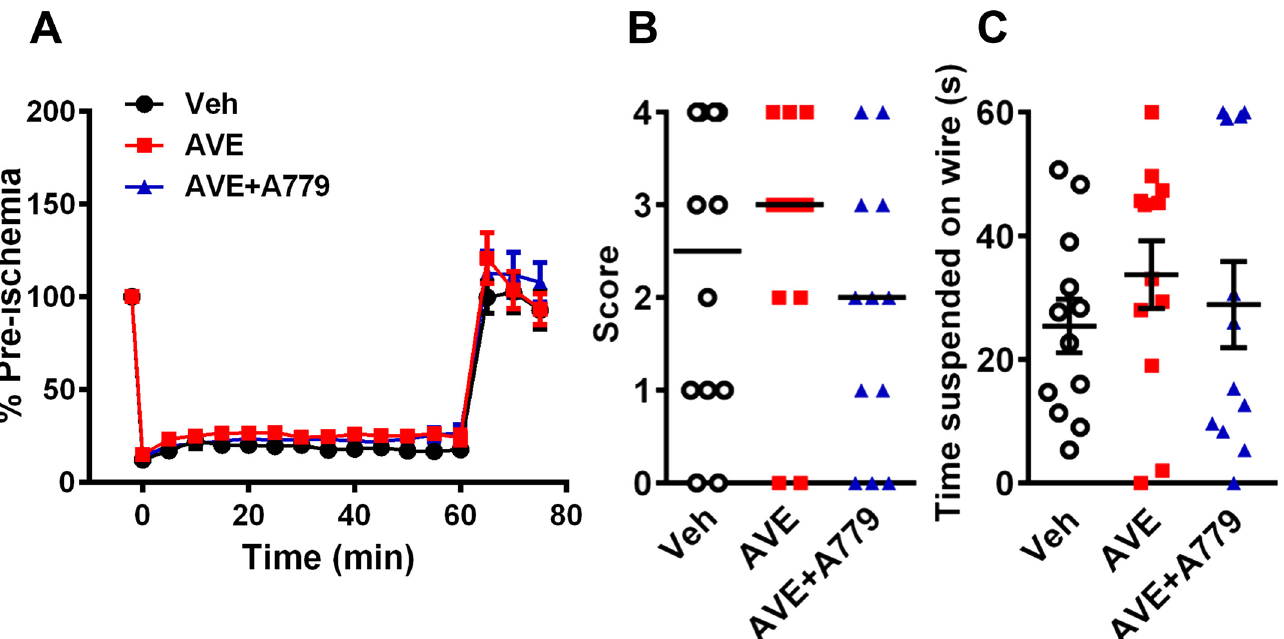
Fig 2. Regional cerebral blood flow and neurological function. Regional cerebral blood flow was recorded during and after 60 min MCAo with reperfusion. Data for (A) regional cerebral blood flow (n = 9 – 12), (B) neurological deficit (vehicle, n = 12; AVE0991, n = 12; AVE0991+A779, n = 12) and (C) hanging wire (vehicle, n = 12; AVE0991, n = 12; AVE0991+A779, n = 12) at 24 h post-MCAo. Data (A) and (C) are presented as mean ± S.E.M. Lines in (B) indicate median scores.